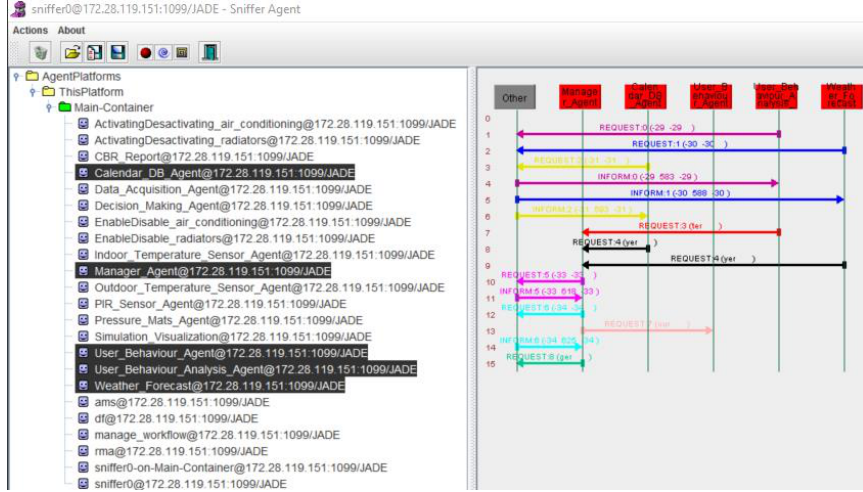
Figure 11. Communication between the agents of the information management layer.